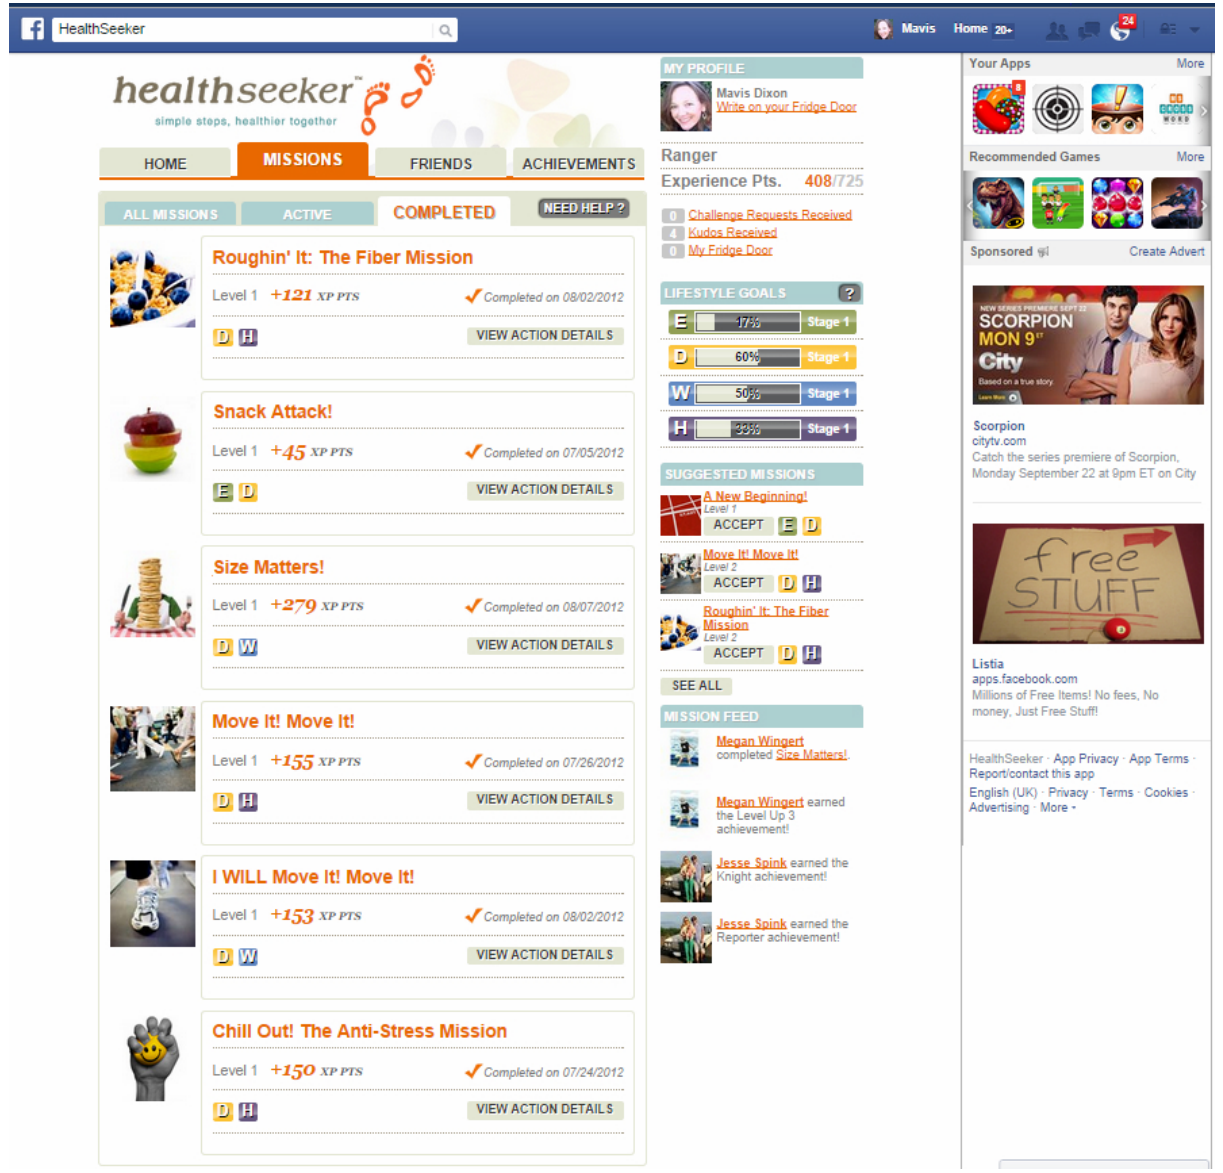
Figure 3. Screenshot of HealthSeeker on